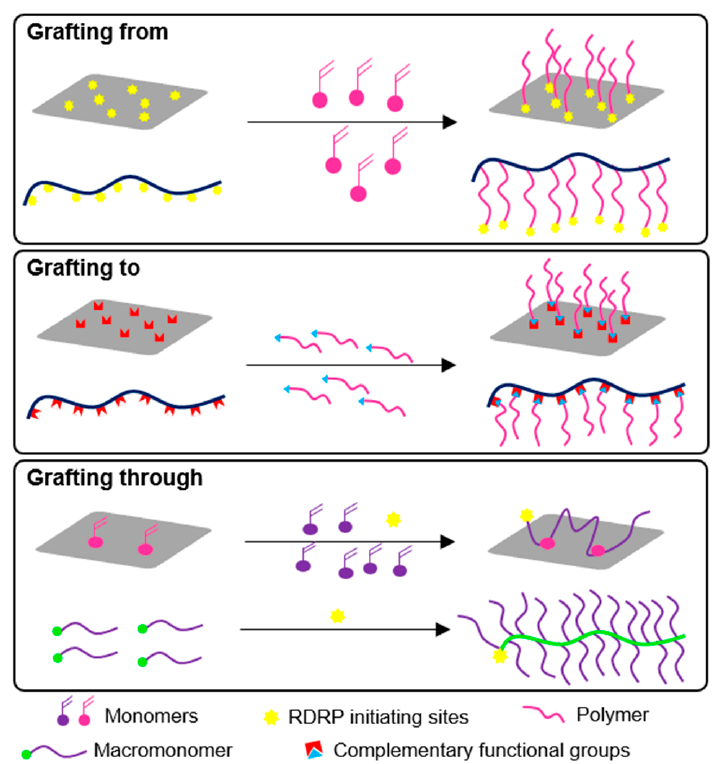
Figure 3. Available strategies for the preparation of polymeric bottlebrushes or immobilized polymer brushes by RDRP techniques: “grafting from,” “grafting to,” and “grafting through.”